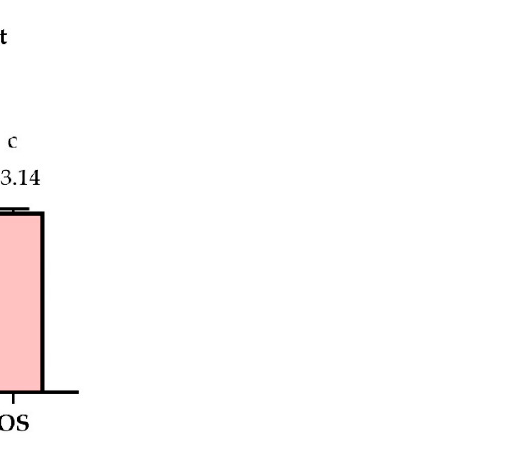
The values are expressed as mean values ± standard deviations of all measurements. a–d t -test was used to compare the means differences registered among samples; data within the same row sharing different superscripts are significantly different ( p < 0.05); data within the same row sharing the same superscripts are not significantly different ( p > 0.05); nd—not